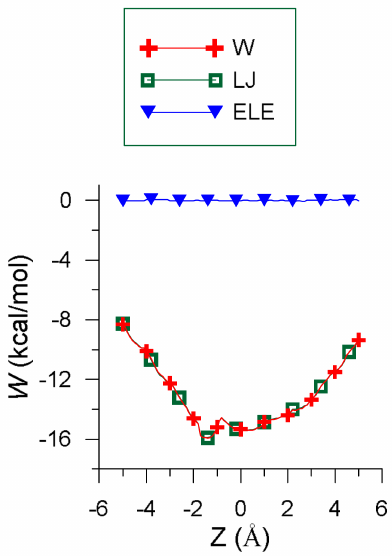
Figure 1. The variation in intermolecular energy ( E inter ) through the cavity ( W ) and its different contributions.